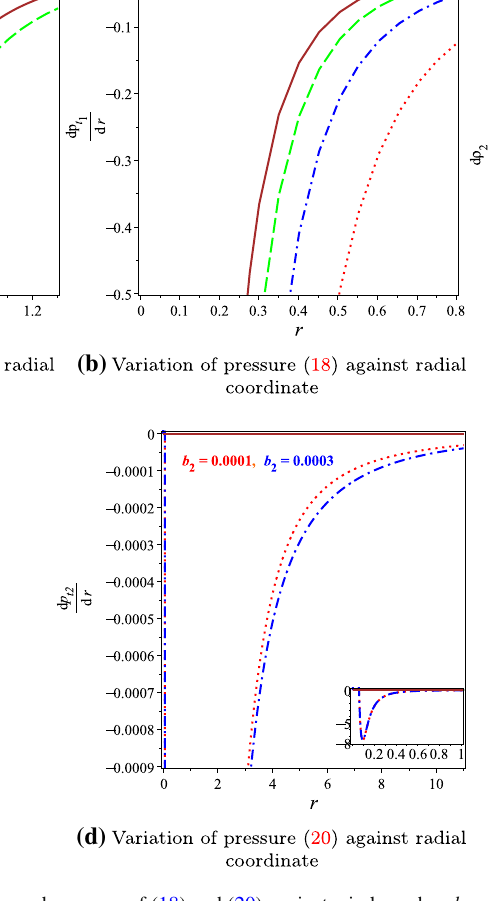
Fig. 4 Variation of the gradient of density and pressure of (18) and (20) against r in km when b 0 = 0 . 0001 and b 1 = 0 .